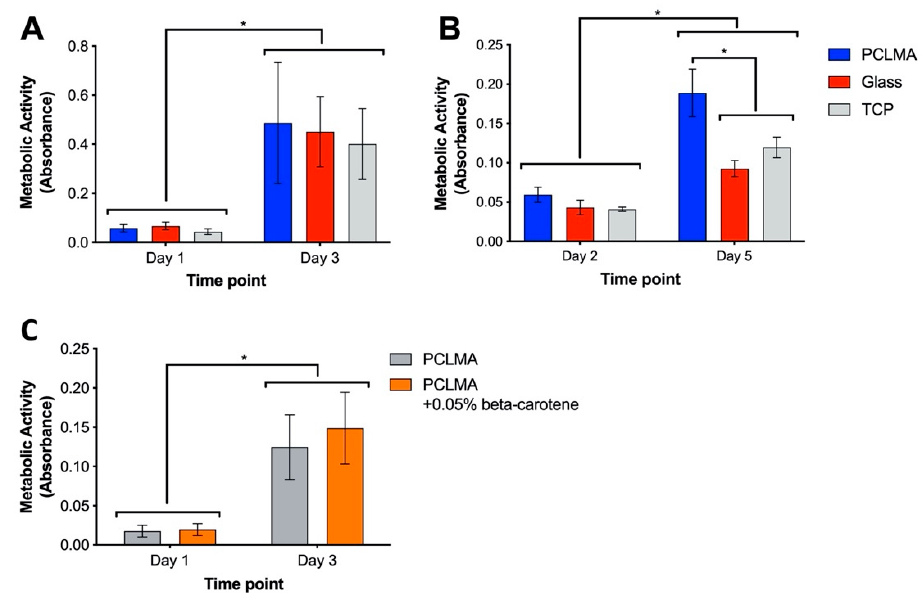
Figure 6. Cytocompatibility testing of 2M20 PCLMA, assessed by MTT assay. ( A ) cytocompatibility assessed with RN22 Schwann cells. (N = 2, n = 3). ( B ) cytocompatibility assessed with rat primary Schwann cells (N = 1, n = 3); ( C ) cytocompatibility testing of β -carotene-containing PCLMA, assessed by MTT assay (N = 3, n = 3). Values displayed mean ± SD. * denotes a significant difference (2-way ANOVA with Tukey’s multiple comparison).